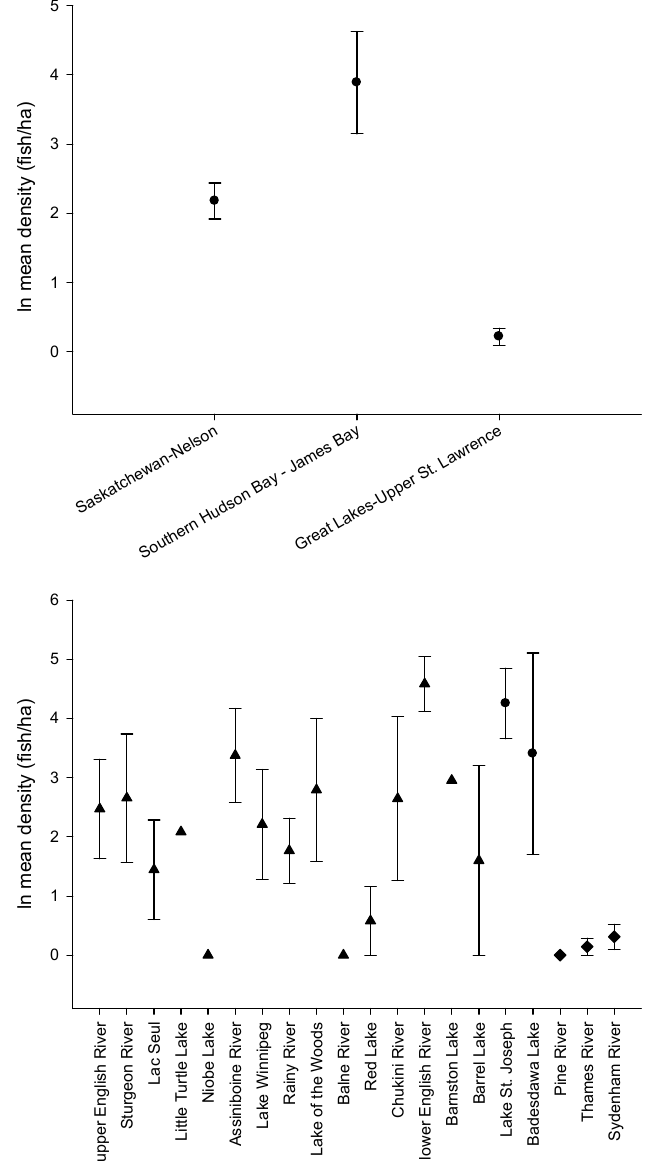
Figure 2. Mean River Darter density from three ecoregions ( top panel ) and individual sites ( bottom panel ) recently (2012–2014) sampled by DFO. The Saskatchewan-Nelson River ecoregion ( ▲ in lower panel) is represented by the fifteen 2014 sampling sites (64 trawls); Southern Hudson Bay-James Bay ecoregion ( ● in lower panel) is represented by two sites (7 trawls); and Great Lakes-Upper St. Lawrence ecoregion ( ♦ in lower panel) is represented by three sites (8 trawls). Error bars represent ± standard error.